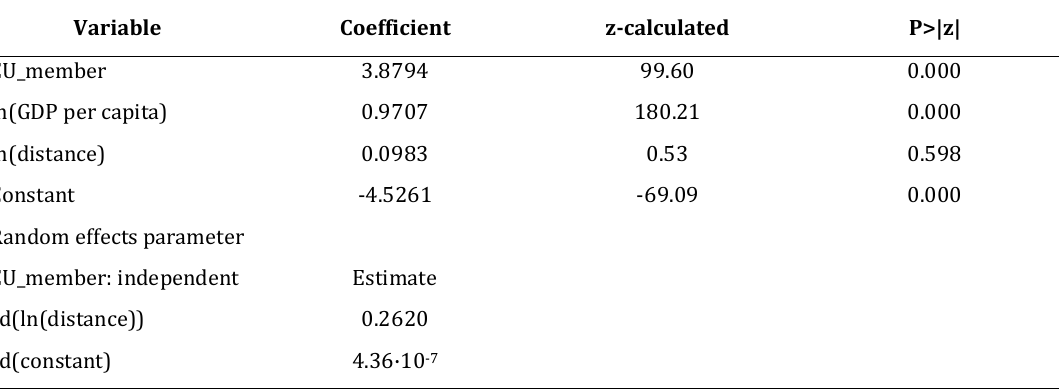
Table 6: Mixed-effects Poisson model for explaining the number safeguarded jobs of the FDI projects in the UK